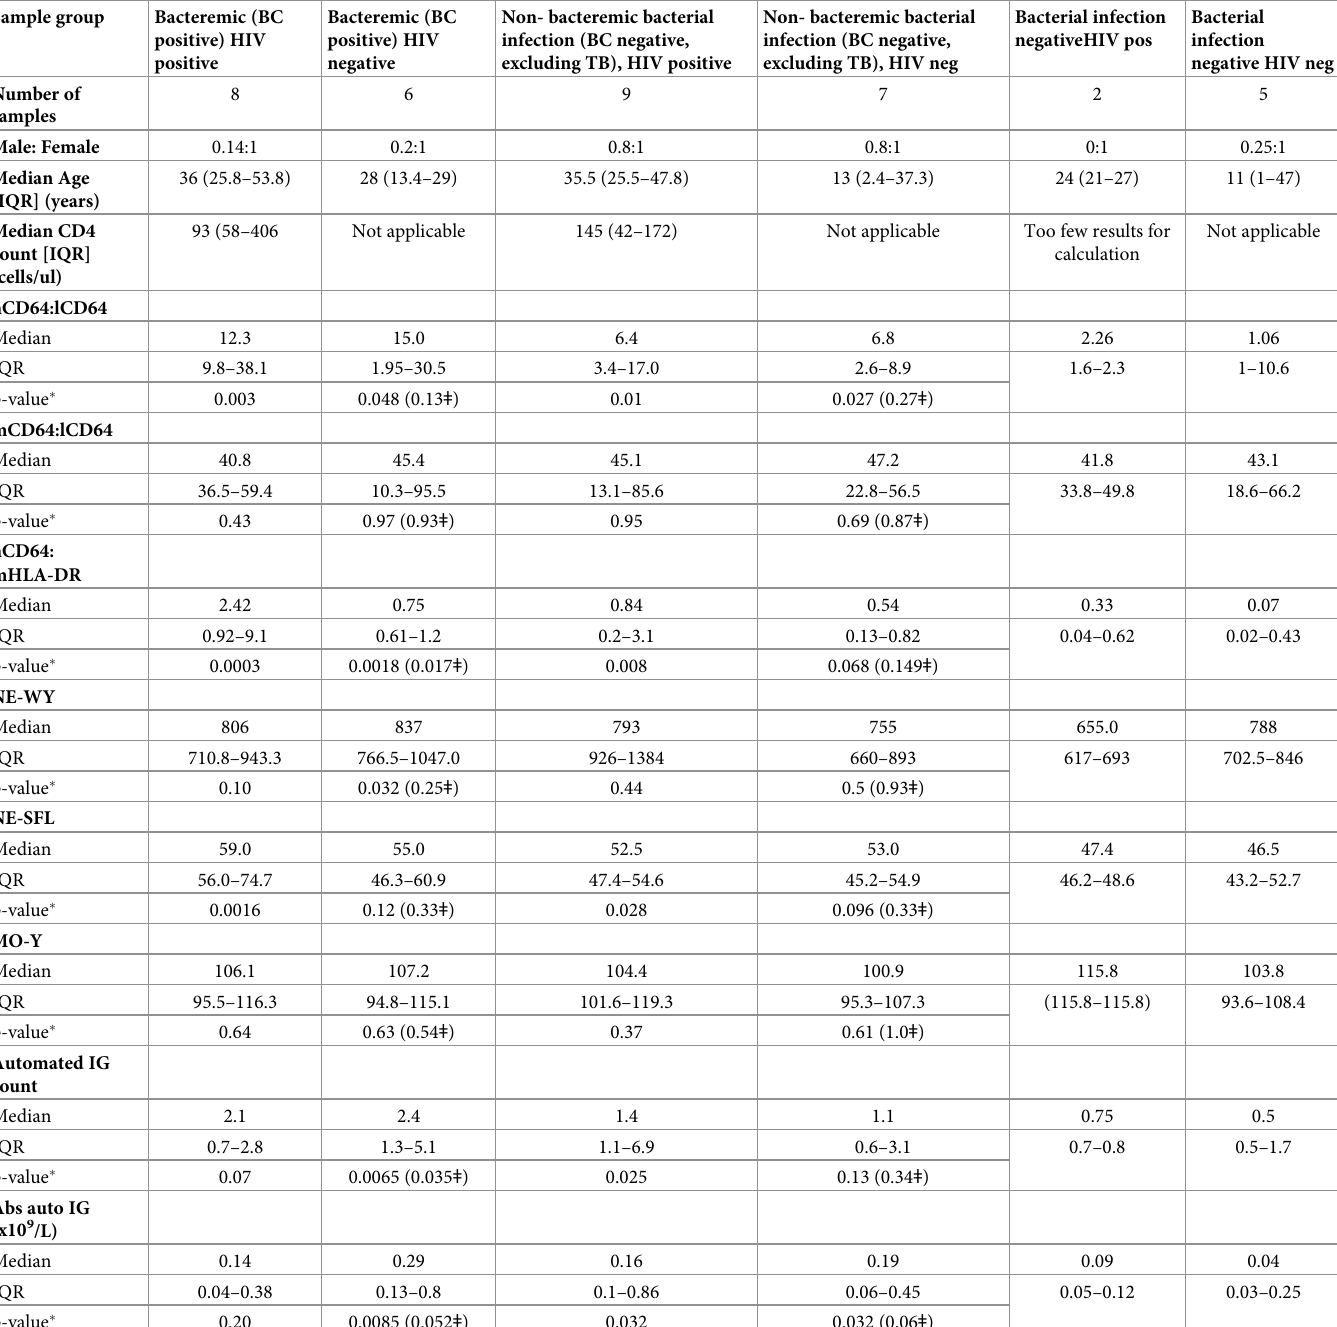
Table 2. Biometrics and EDP data of samples with unequivocal results stratified according to HIV